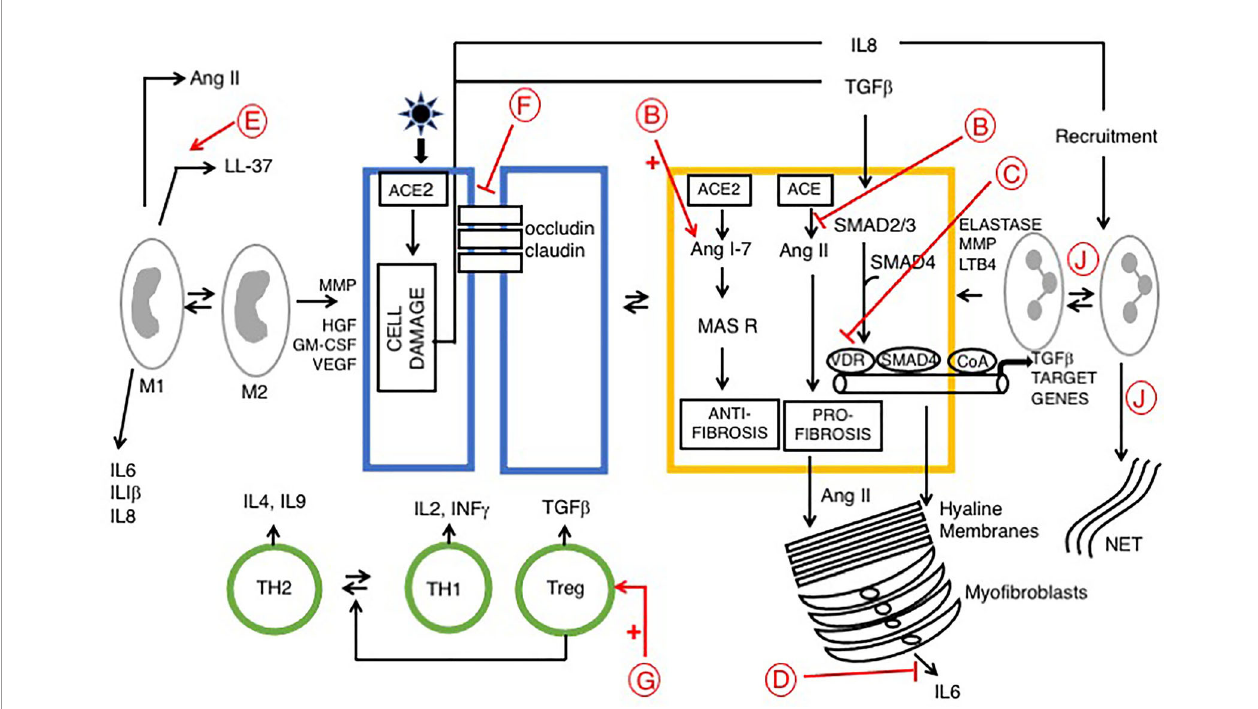
FIGURE 1 | Signaling pathways in late phase ARDS in patients with COVID-19; role of vitamin D Disease progression is in fl uenced by stromal/in fl ammatory in fi ltrate. Epithelial cells are colored blue, lung stellate cells (yellow), lymphocytes (green), and myeloid cells: macrophages M1, M2 and neutrophils (grey). SARS-CoV-2 infected alveolar type II epithelial (ATE2) cells release IL8, recruiting in fl ammatory cells, with neutrophil secretion of IL-6 contributing to the cytokine storm. Lung fi brosis occurs via two pathways. Macrophages and lung stellate cells secrete angiotensin II, promoting myo fi broblast formation and increasing ECM formation with hyaline membrane disease. ATE2 cells secrete TGF- b , which drives the myo fi broblast phenotype. Predicted effects of vitamin D are labeled in red A – J as described in Table 6 , where labels indicate: B: Increased ACE/Ang II/AT1R signaling; C: Down-regulation of TGF- b -SMAD-dependent transcription; D: Inhibition of pro- in fl ammatory chemokine release; E: Increased antimicrobial peptides, defensins and cathelicidin; F: Maintains epithelial cell tight-junction integrity; G: Increased Treg activity; J: Decreased Neutrophil activity and increased NET formation. VDA effects D and E are likely more relevant in early stage COVID-19 respiratory tract